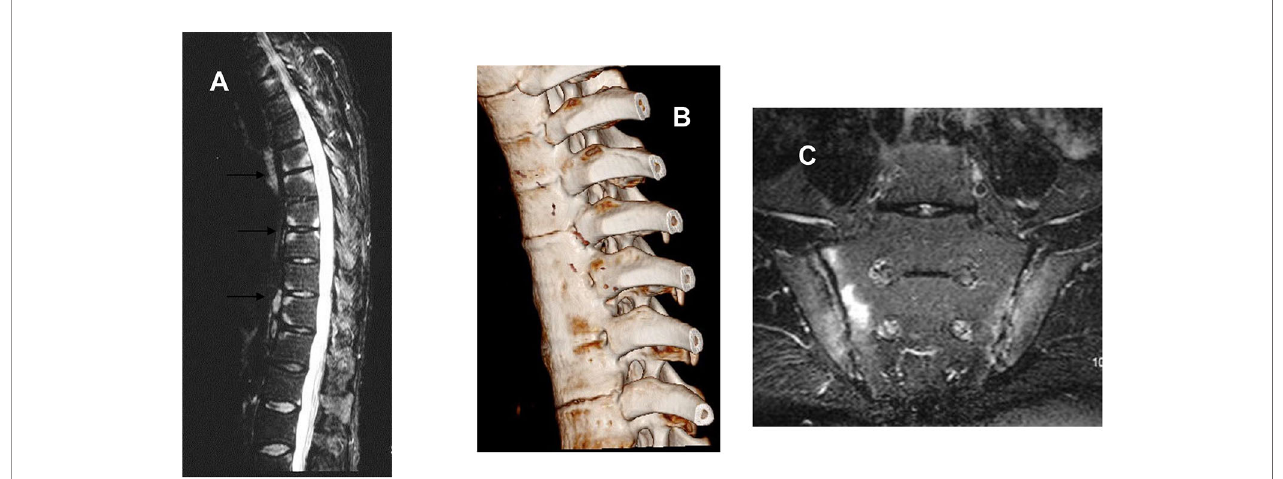
FIGURE 1 | (A) Sagittal magnetic resonance image of the thoracic spine of a 44-year-old man with active ankylosing spondylitis, showing high signal on these T2- weighted images consistent with in fl ammation at the vertebral corners consistent with the attachment of vertebral ligaments and discs. (B) Computed tomographic reconstruction of the thoracic spine of a 25-year-old man with AS since the age of 12. There is clear bony fusion between the adjacent vertebrae and also at the costovertebral joints. (C) Bilateral sacroiliitis shown by MRI (STIR sequence) worse on the sacral side of the right SI